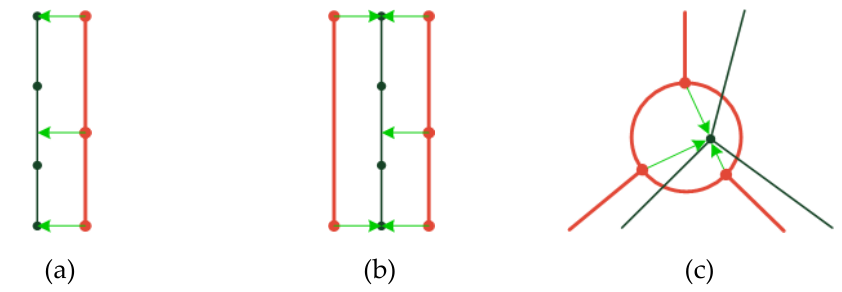
Figure 2. Identified matching pairs with different matching relationships: ( a ) m:n matching; ( b ) Equivalent matching (parallel lines to single line); ( c ) Equivalent matching (polygon to point). Black lines: road network 1; red lines: road network 2; green arrows: linkages.